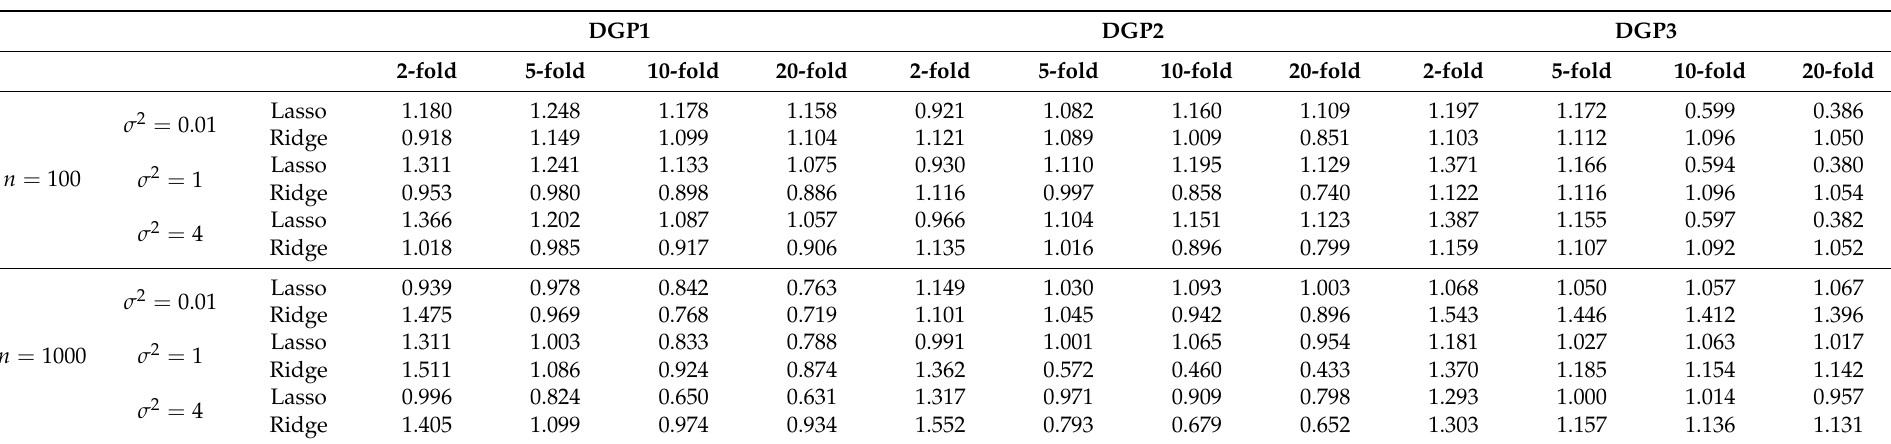
Table A4. Mean ratio of claimed SE and true SD: independent predictors and constant